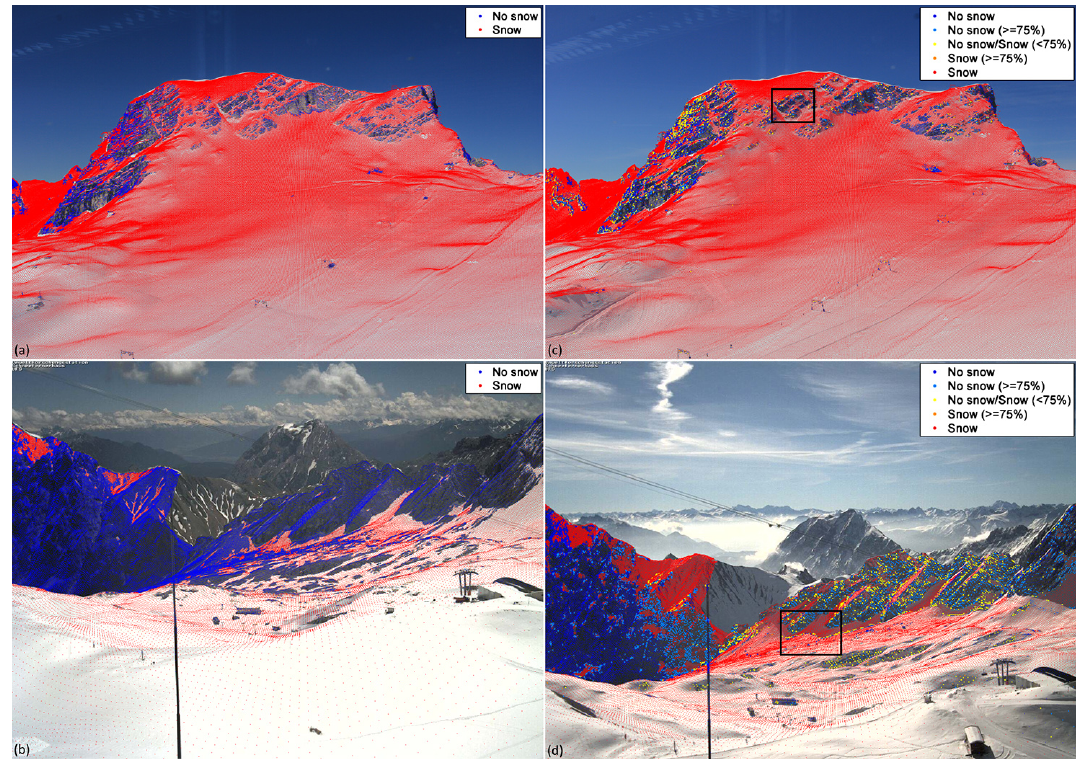
Figure 10. Superimposed snow classifications on the SLR and webcam photographs of 1 July 2013 and 7 April 2014: the SLR (a) and webcam (b) photographs of July 2013 utilized the blue band classification routine of Salvatori et al. (2011) depicting snow in red and no snow in blue. The new PCA-based classification method is, however, applied for the SLR (c) and webcam (d) photographs of April 2014. Here, snow and snow-free pixels are again displayed in red and blue but additionally unsure classification results are illustrated in light blue, yellow and orange for the categories probably no snow , highly unsure , and probably snow . Black rectangle boxes in (c) and (d) are depicted for detailed analyses of the classification accuracy (Fig. 11a and